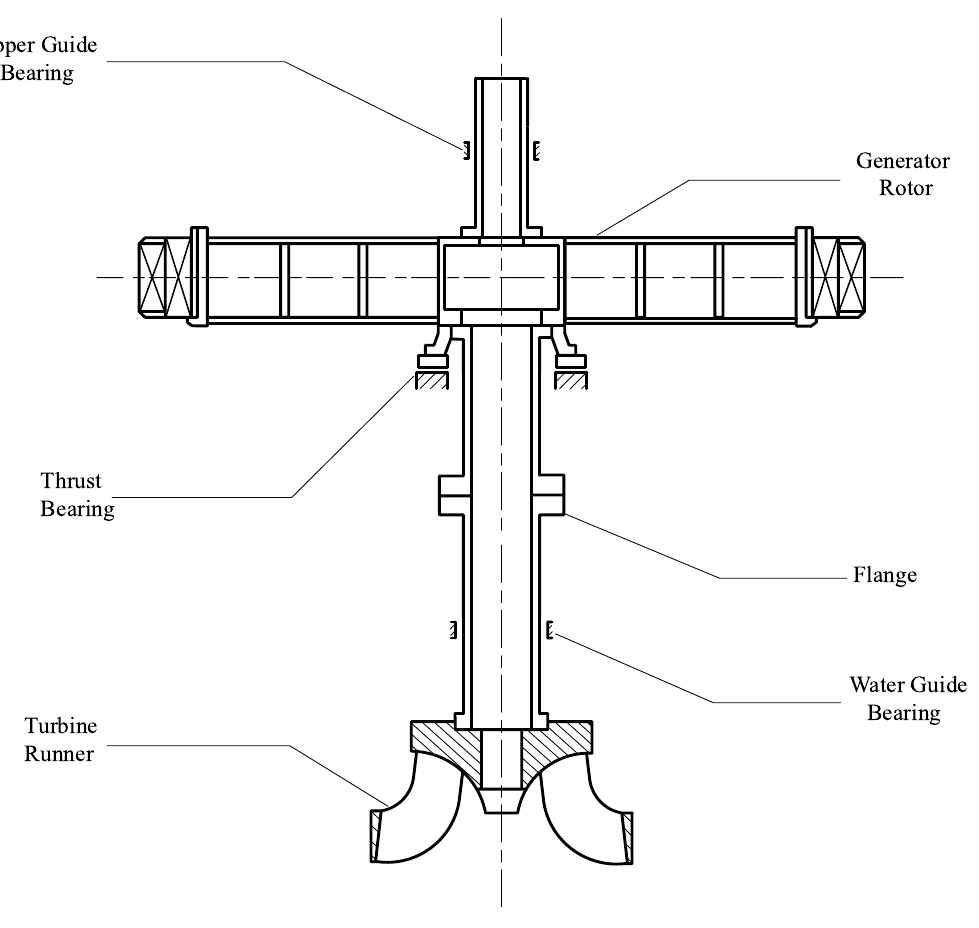
Fig. 1. Schematic diagram of the shaft system of hydroelectric generating set.